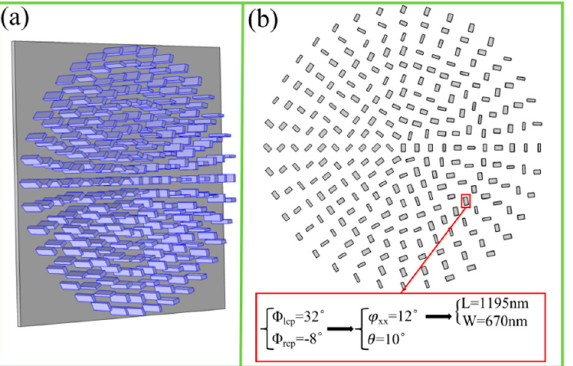
Figure 2. ( a ) Schematic of the spin-selected vortex metalens. ( b ) Top view of spin-selected vortex metalens, and the designing concept and specific parameters’ selection of a unit cell.